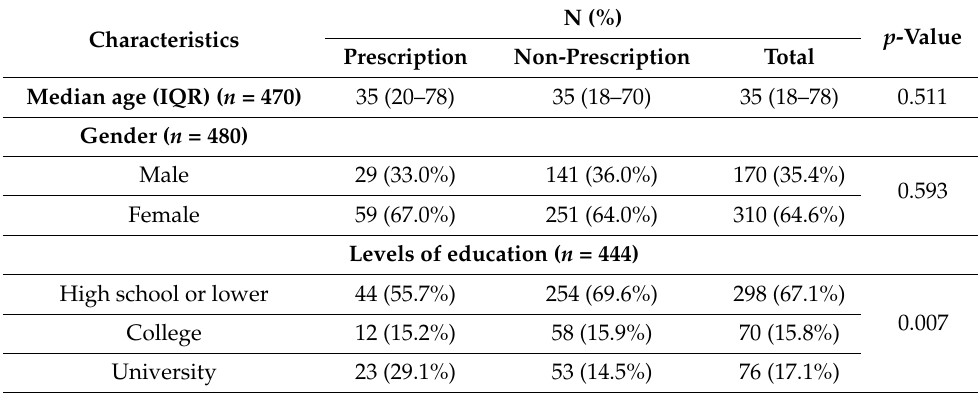
Table 2. Demographic characteristics of participants purchasing antibiotics